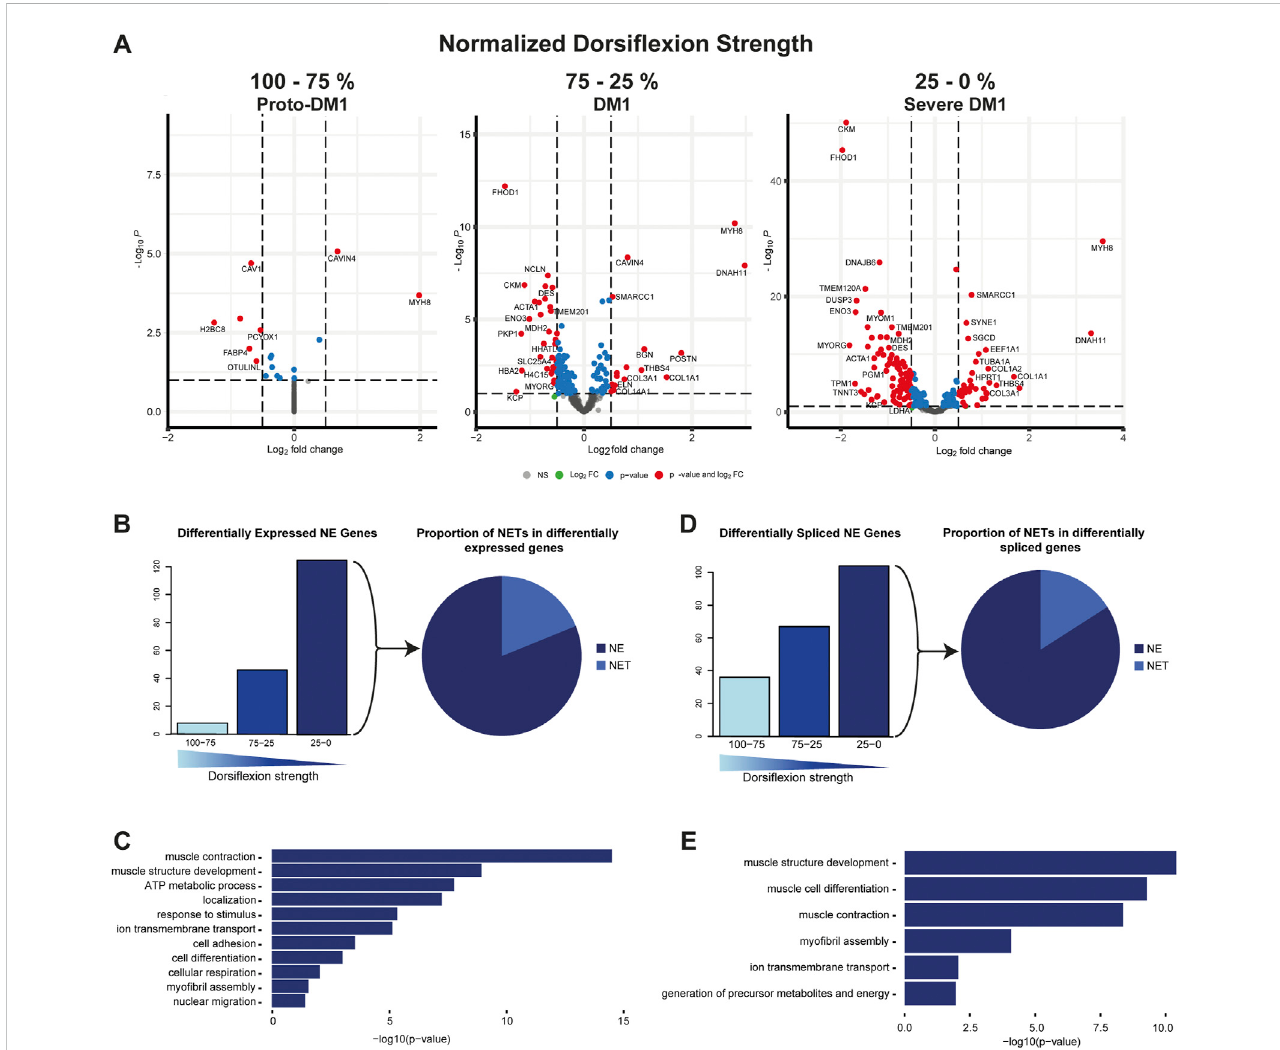
FIGURE 1 Musclenuclearenvelope(NE)proteinsaredifferentialexpressedandsplicedinDM1. (A) Geneexpressionof386muscleNEproteinsforproto-DM1,DM1, and severe DM1 based on dorsi fl exion strength. (B) Number of genes being differential expressed and the proportion of NE transmembrane proteins (NETs). (C) GO-termenrichmentforthedifferentialexpressedmuscleNEproteins. (D) NumberofgenesbeingdifferentialsplicedandtheproportionofNETs. (E) GO- term enrichment for the differential spliced muscle NE